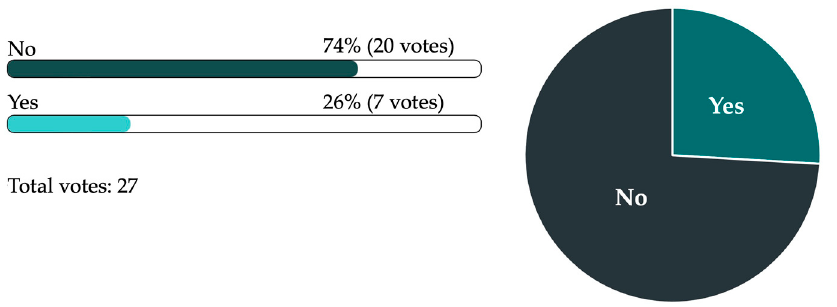
Figure 4. Results from the online survey among specialists in oral and maxillofacial surgery during the 36th Swiss Congress of Oral and Cranio-maxillofacial Surgery regarding their knowledge about the existence of dental and maxillofacial “medStandards”.